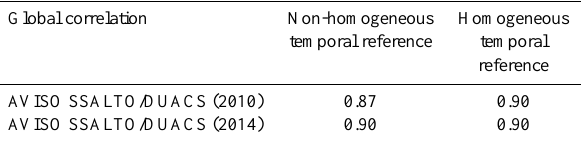
Table 2. Global correlation (with a 95% confidence interval) be- tween all collocated altimeter SLAs (AVISO SSALTO/DUACS, 2010 and 2014; Pujol et al., 2016) and in situ DHAs from Argo pro- files (with a reference depth of 1900dbar and a 2003–2011 temporal reference) without and with an homogeneous temporal reference.